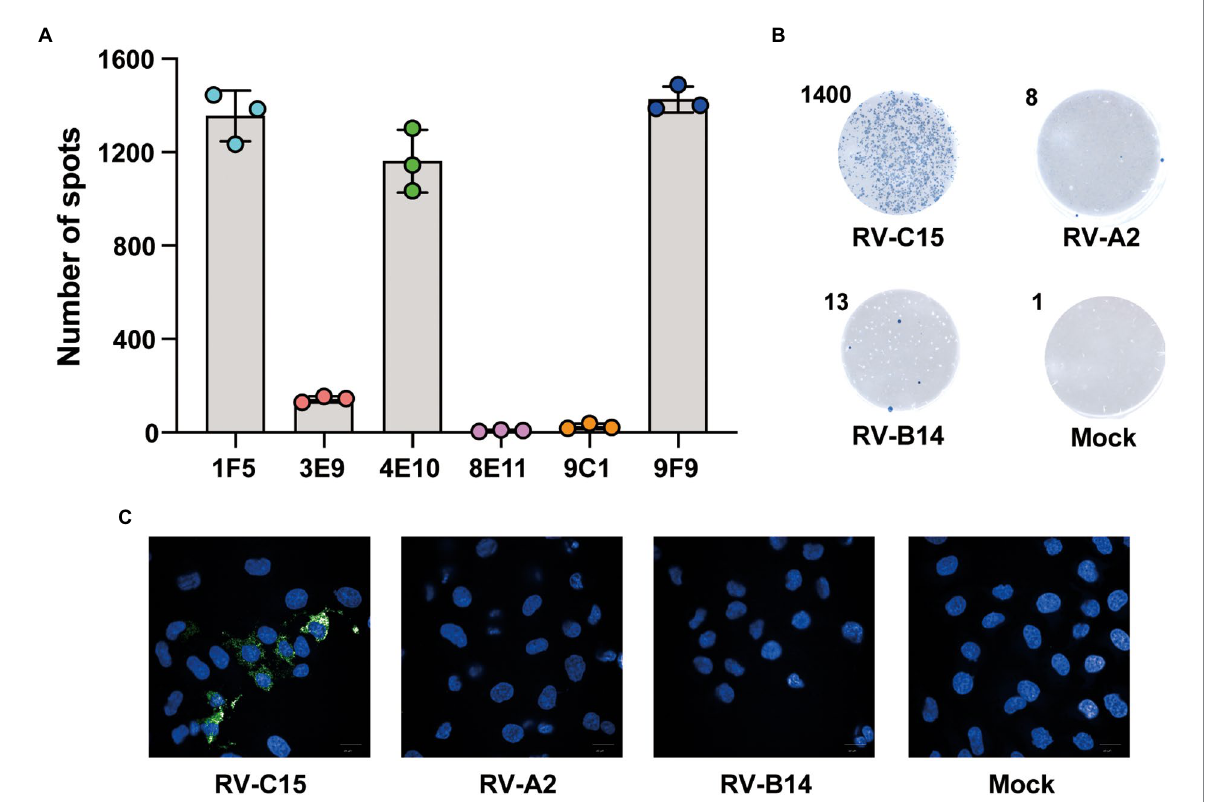
FIGURE 3 Characterization of the detection antibody in the Nt-ELISPOT. (A) Spots detection with different MAbs. Six MAbs produced from mice immunized with RV-C15 were conjugated with HRP and used for the development of the Nt-ELISPOT. Spots were counted by the ImmunoSpot image analyzer. (B) Specificity analysis for detection antibody 9F9. RV-C15-, RV-A2-, or RV-B14-infected cells and uninfected cells (Mock) were fixed and incubated with HRP-9F9. The RV-C15-infected cells were visualized as blue spots after staining. Representative cell wells are shown. The number in the upper left corner indicates spots counted by the ImmunoSpot@S5 UV Analyzer. (C) Immunofluorescence analysis for detecting antibody 9F9. RV-C15-, RV-A2-, or RV-B14-infected cells and uninfected cells (Mock) were fixed and incubated with 9F9. The secondary antibody was Alexa Fluor ® 488 conjugated (green). The nuclei were stained with DAPI (blue). Scale bar = 20 μ